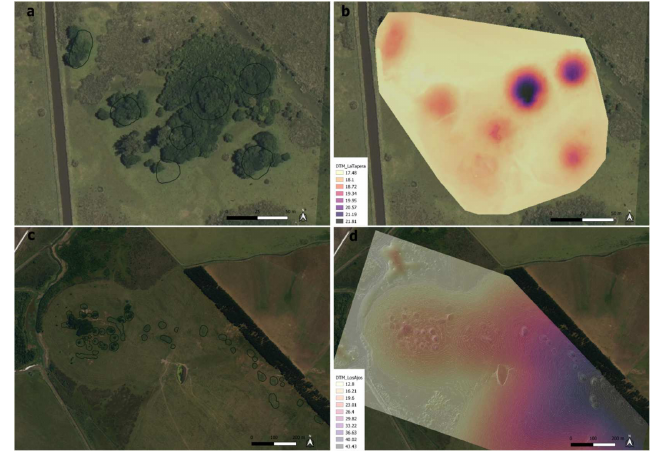
Figure 3. Geospatial record of earthworks in the field. ( a , b ) Orthoimage with GPS polygons of the different earthworks and DTM created via topography with total station of the La Tapera ensemble of mounds. ( c , d ) Orthoimage with GPS polygons of different earthworks and DTM created via drone photogrammetry of the Los Ajos mound site.